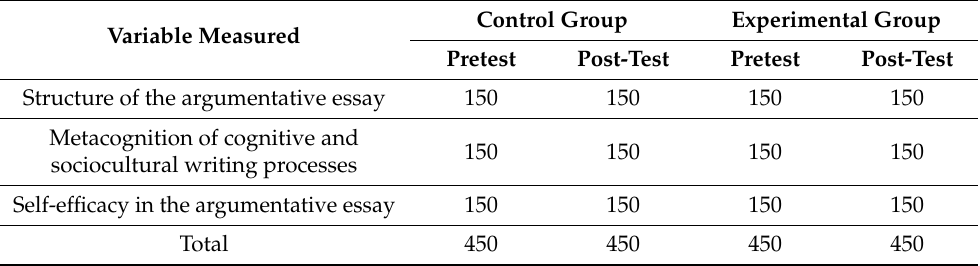
Table 3. Quasi-experimental research design. Control Group Experimental Group Variable Measured Pretest Post-Test